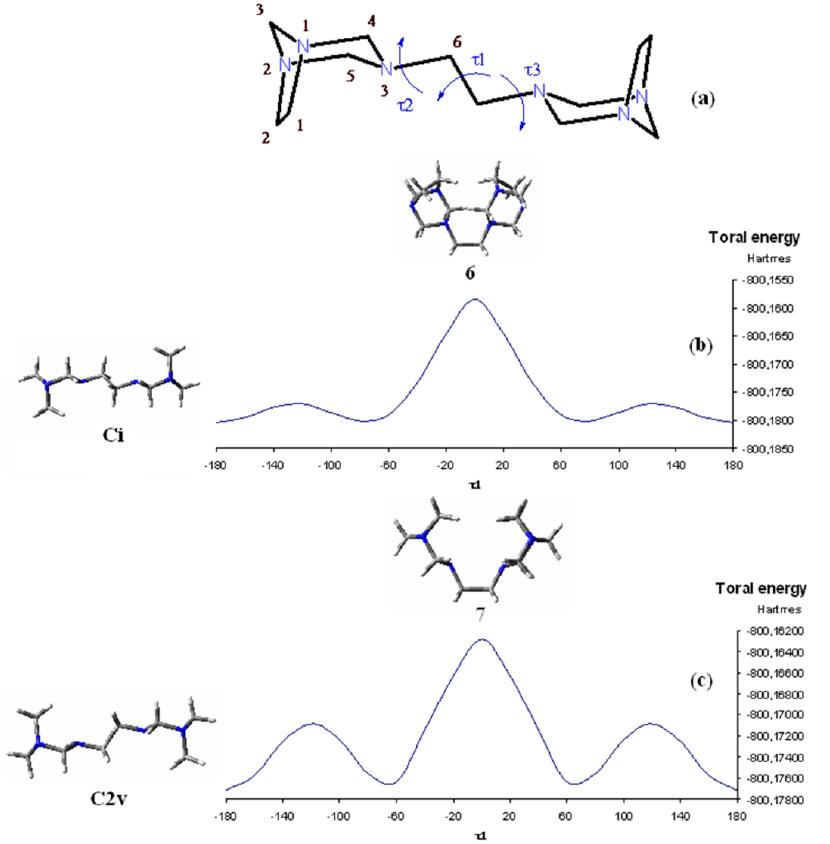
Figure 7. ( a ) Dihedral angles around N3–C6, C6–C6 ′ and C6 ′ –N3 ′ ( b ) B3LYP/6-31G(d,p) potential energy surface scan of the N3–C6–C6 ′ –N3 ′ dihedral angle of C i conformer, ( c ) B3LYP/6-31G(d,p) potential energy surface scan of the N3–C6–C6 ′ –N3 ′ dihedral angle of C 2v conformer.